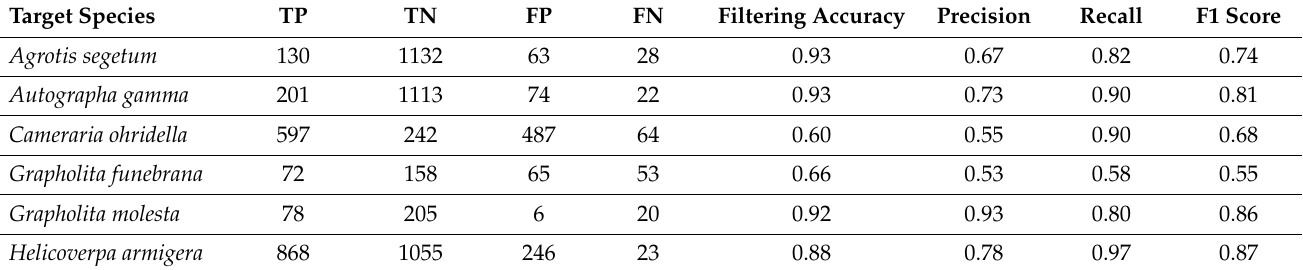
Table 2. The performance summary of ANN data filtering procedures. TP: true positive, TN: true negative, FP: false positive, FN: false